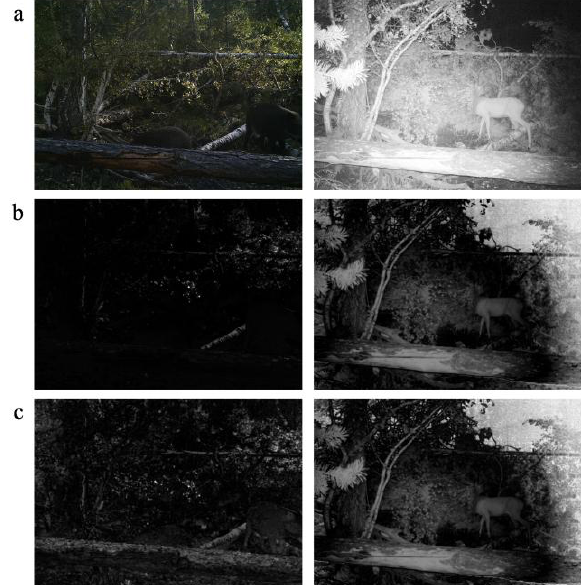
Figure 6. Example of saliency maps: a) original images, b) saliency map level 1, c) saliency map with 2